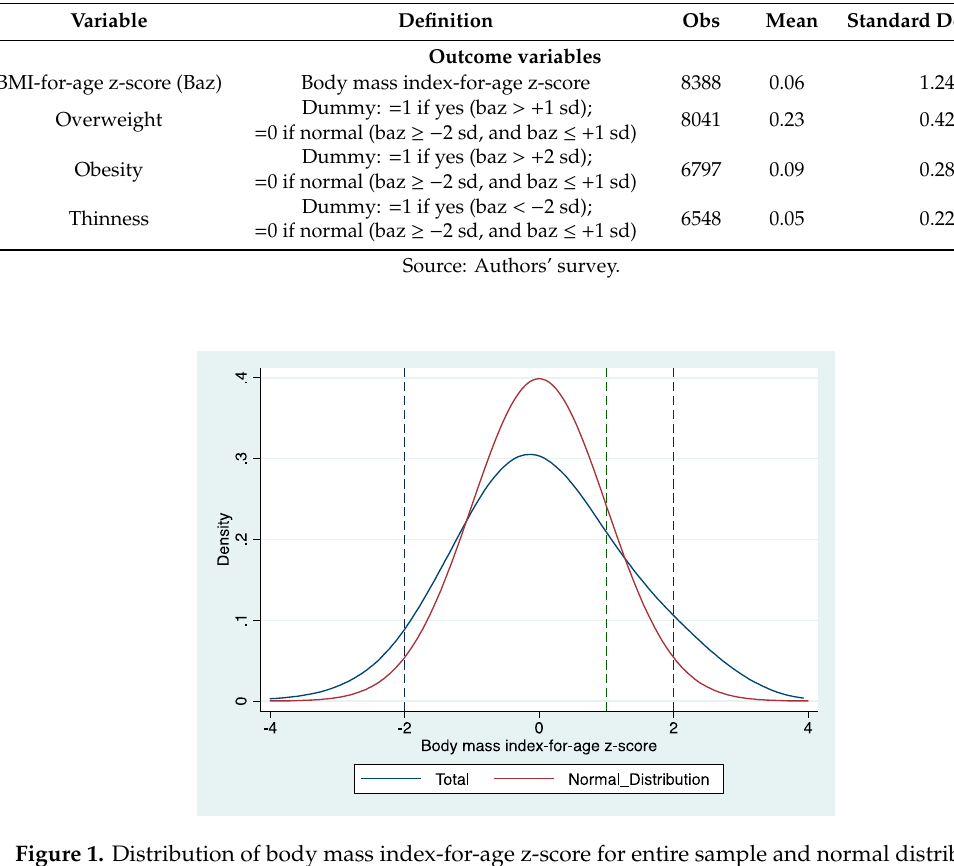
Table 1. Summary statistics of outcome variables.